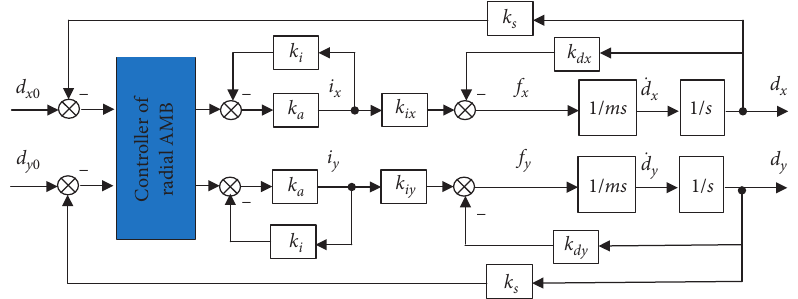
Figure 9: Control diagram of the magnetic suspension system in radial